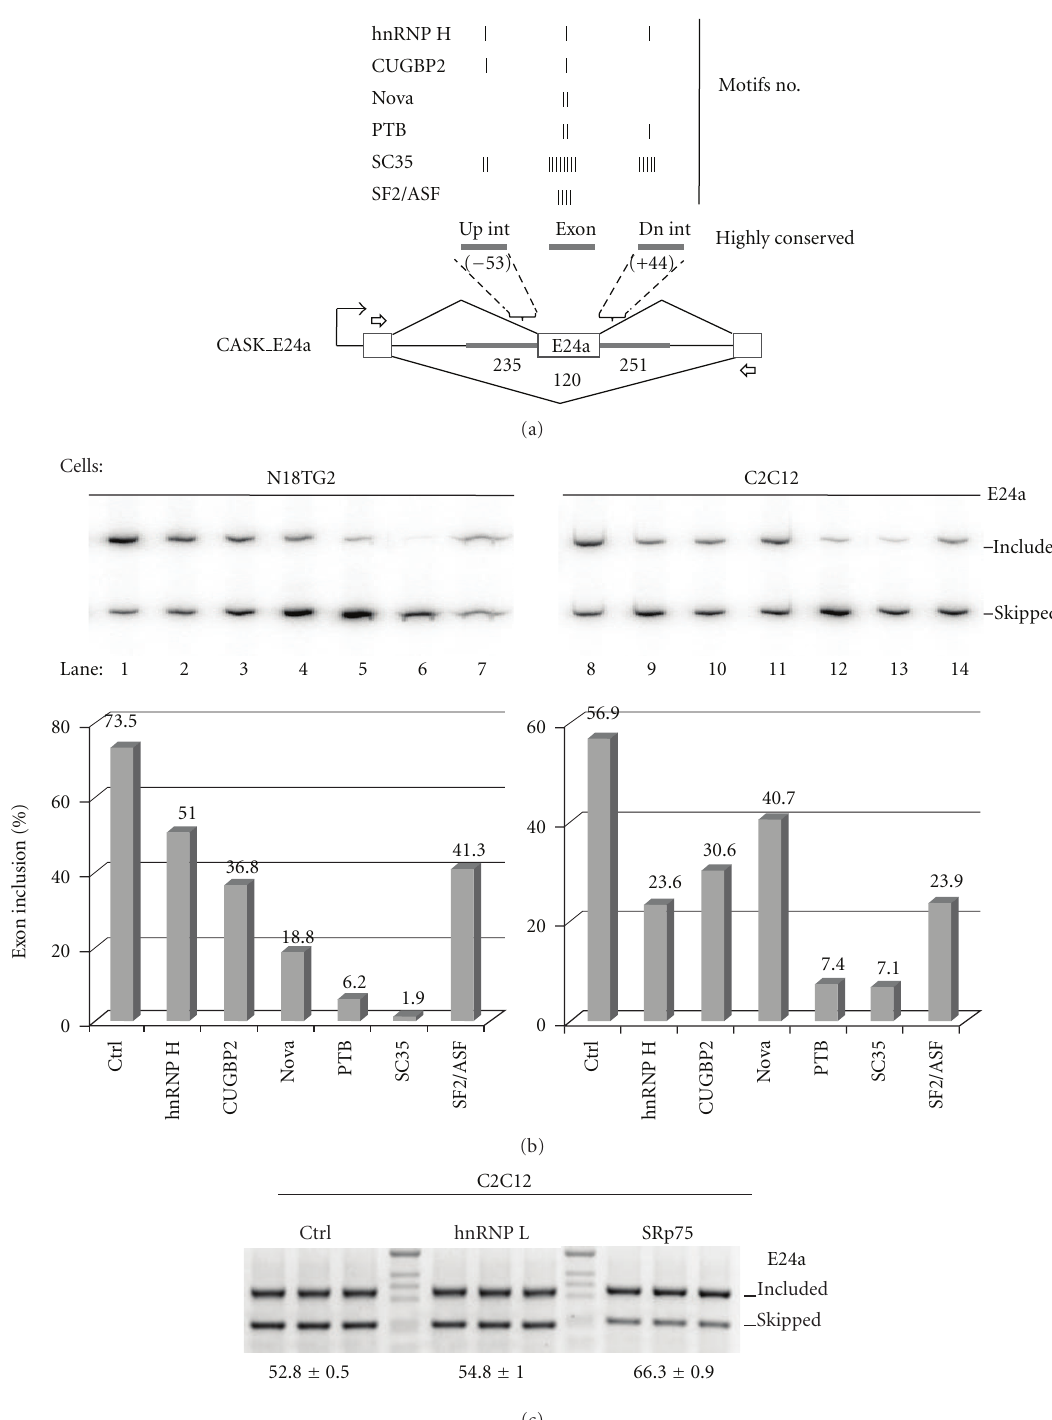
Figure 5: Exon skipping is induced by factors with conserved motifs in close proximity to E24a. (a) The CASK E24a splicing reporter is shown with the motif copy number for each splicing factor tested in the experiment represented by tick marks in the most highly conserved block corresponding to Supplementary Figure S5: upstream intron (up int), exon, and downstream intron (dn int). (b) Gel panels display the products from splicing reporter assays (E24a included and skipped) in N18TG2 and C2C12 cells. Transfections were performed with protein expression plasmids: hnRNP H (lanes 2, 9), CUGBP2 (lanes 3, 10), Nova (lanes 4, 11), PTB (lanes 5, 12), SC35 (lanes 6, 13), and ASF/SF2 (lanes 7, 14). Control samples (ctrl) were transfected with an equivalent amount of empty vector plasmid (lanes 1, 8). Bar graphs illustrate the % exon inclusion values for the gel panels above. (c) The CASK E24a splicing reporter was cotransfected into C2C12 cells with an empty vector control (Ctrl), hnRNP L, or SRp75 protein expression vectors. Transfections and RT-PCR amplification from the flanking exons were carried out in triplicate. Percent exon inclusion is indicated below the gel panel, ± standard